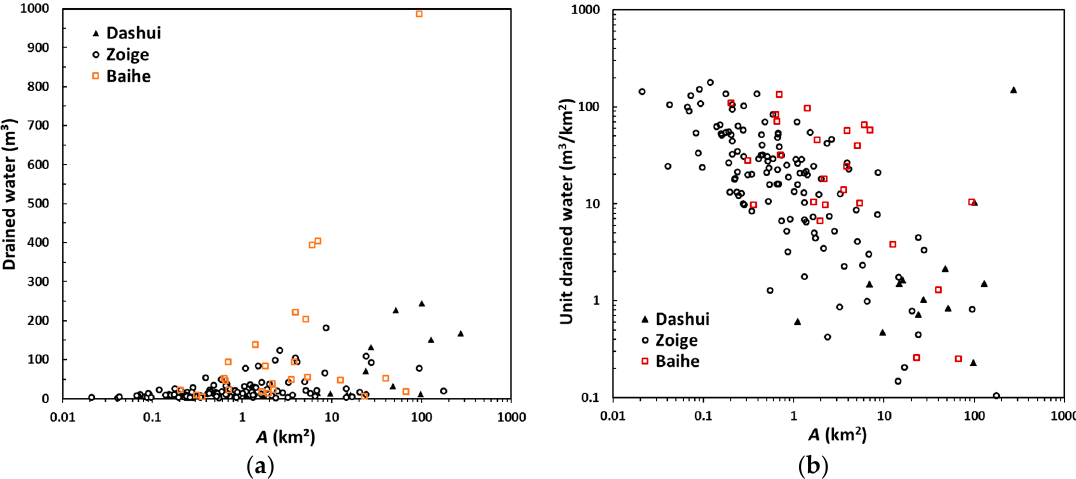
Figure 7. Patterns of drained ditch water in all peatland patches grouped into three zones (subareas) with regard to their areas in 1986. ( a ) Volume of the total drained water and ( b ) volume of the total drained water per unit area of each patch.